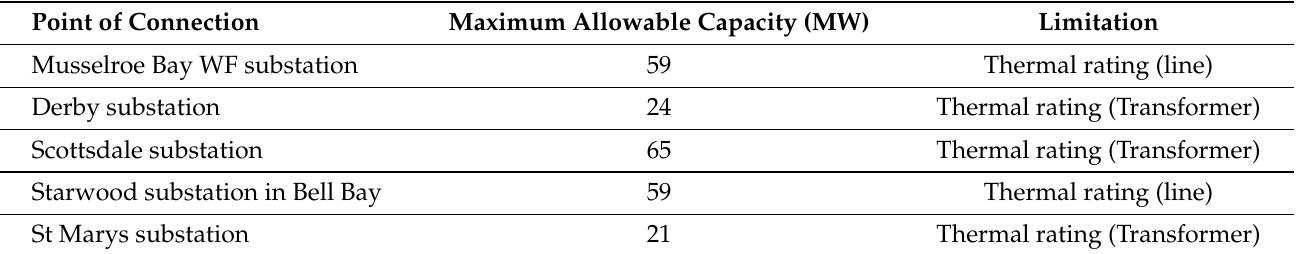
Table 3. Locational tidal HC at different locations in the Tasmanian